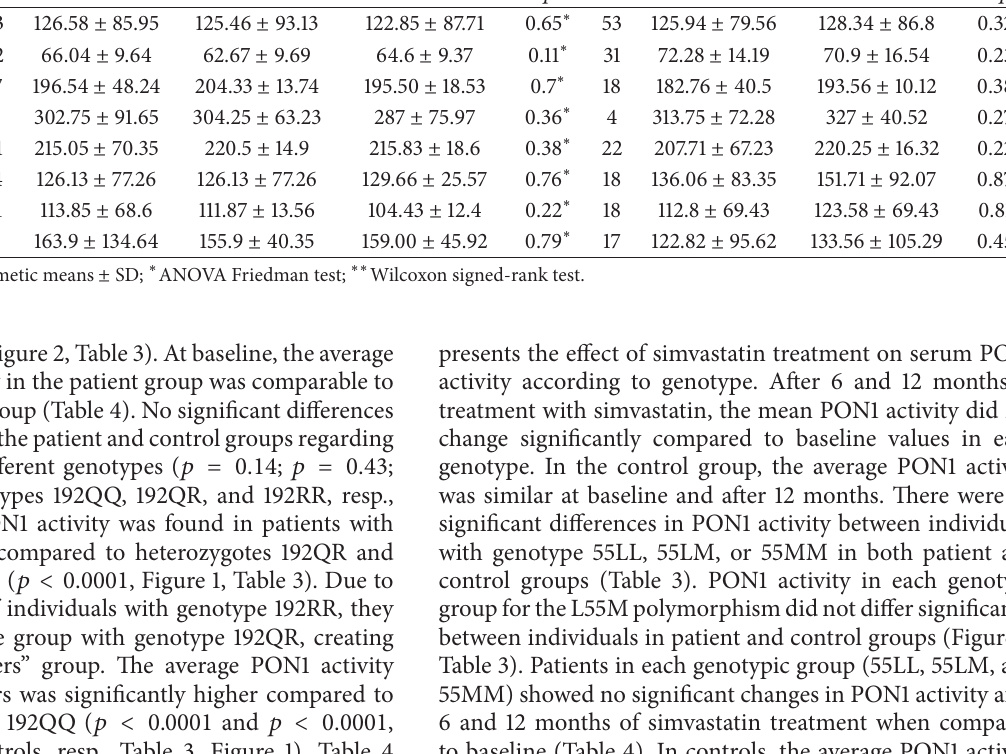
Table 4: The effect of Q192R and L55M polymorphisms on serum PON1 activity before and after treatment with simvastatin. CAD Genotype